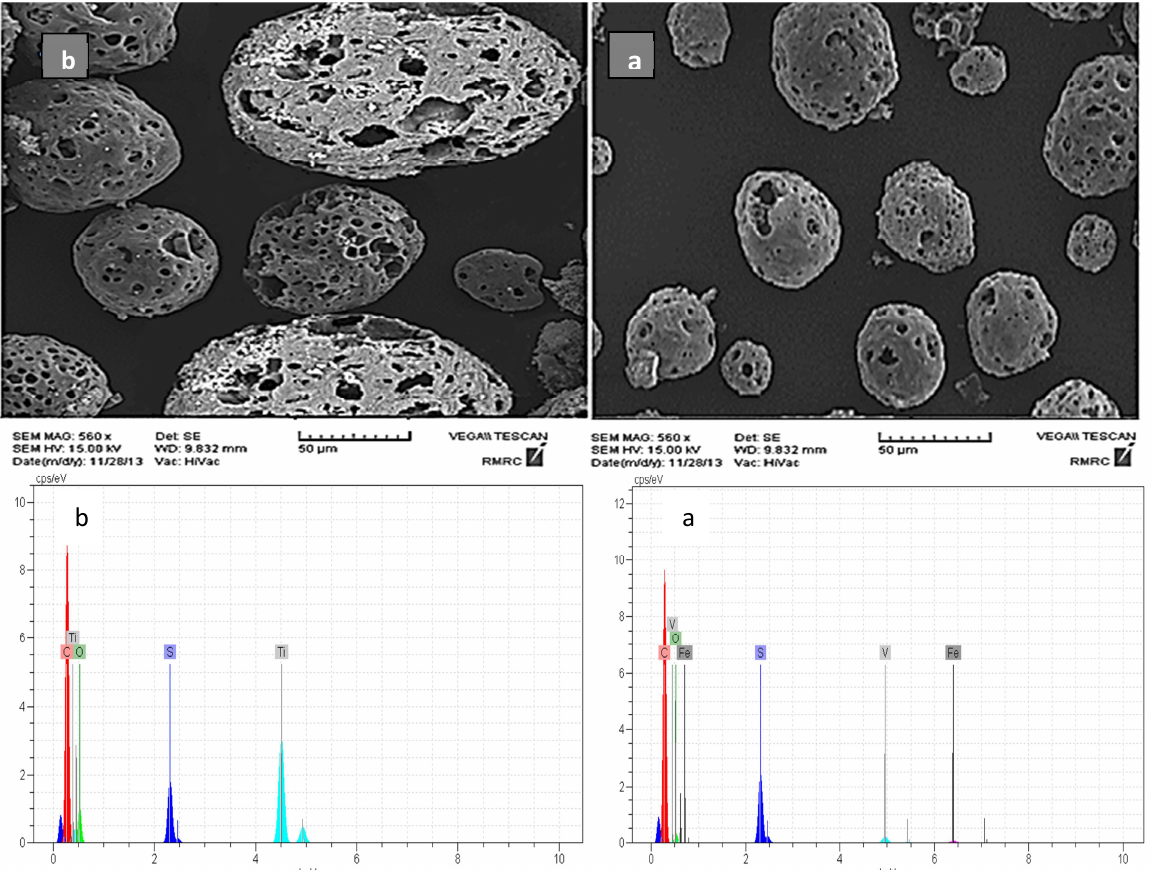
Figure 1. Scanning Electron Microscopy-Energy-dispersive X-ray Spectroscopy (SEM-EDS) images of raw fly ash (a) modified fly ash (MFA)-TiO